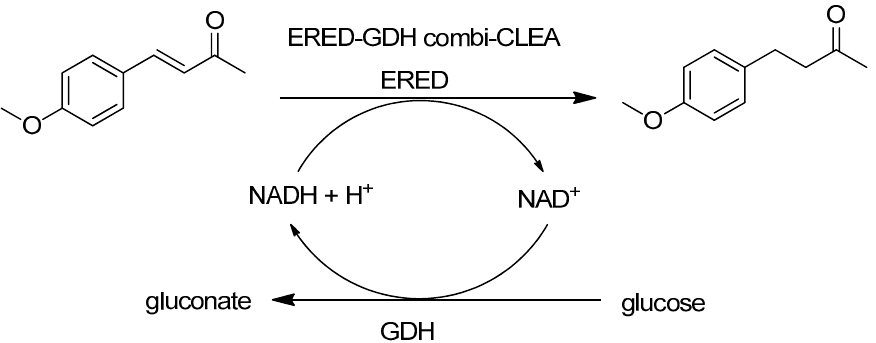
Figure 7. Enoate reductase/glucose dehydrogenase (ERED/GDH)-combi-CLEA.